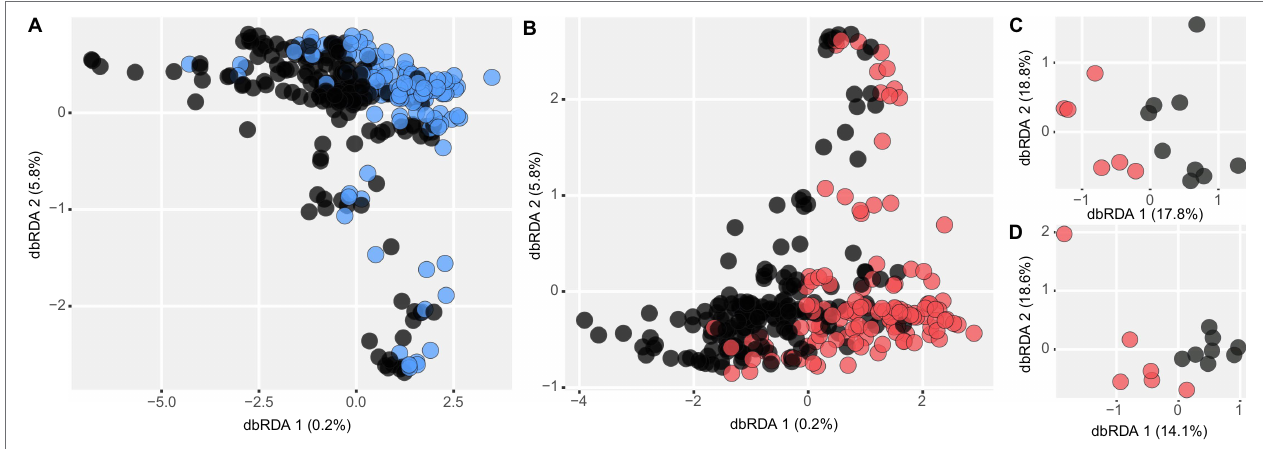
FIGURE 4 | Distance-based redundancy analysis showing the variation of the diazotrophic community (A) due to P and (B) due to N addition. Significant community shifts detected in (C) konz.us and (D) look.us after 4 years of chronic N fertilization. Nutrient-treated samples are depicted in blue (P) and red (N); respective control samples are represented in